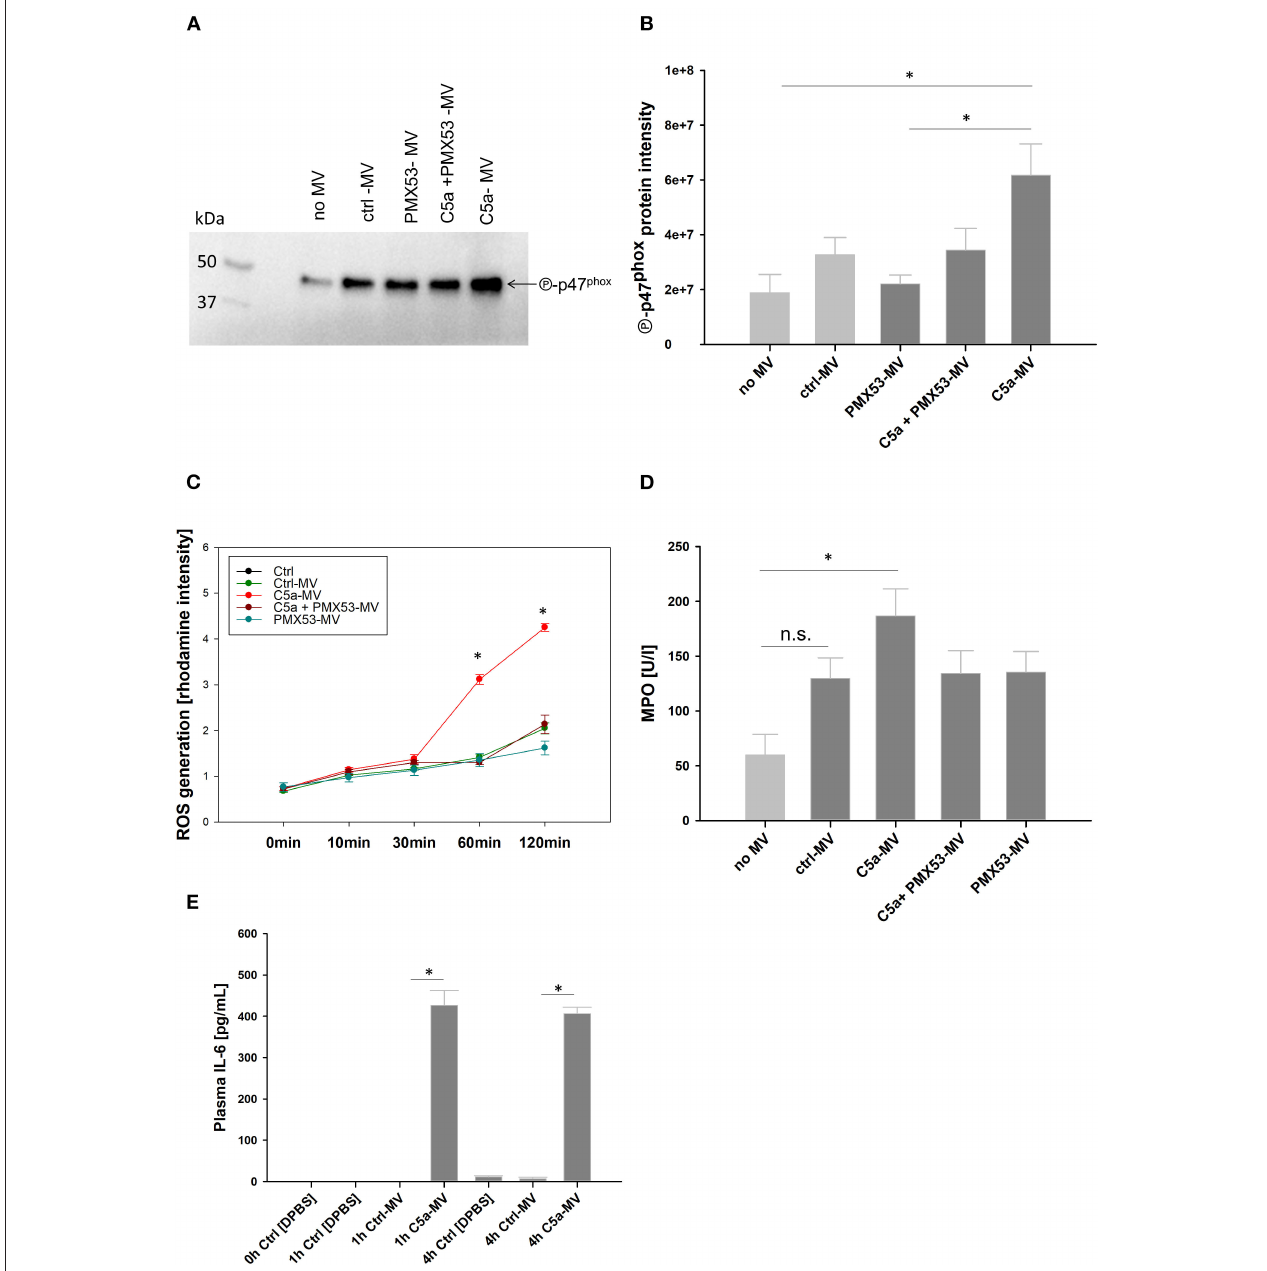
FIGURE 7 | Inflammatory feature of PMN-derived MVs. (A) One representative immunoblot probed for phospho-p47 phox of whole cell lysates from PMNs. PMNs were treated with C5a, C5a and PMX53, and PMX53 only. Untreated PMNs served as control. Afterwards, PMNs from autologous donors were incubated with the generated MVs for 1h at 37 ◦ C. PMNs without MV stimulation served as control. (B) Quantification of phospho-p47 phox signal intensity of PMNs whole cell lysates from three donors. * p < 0.05 compared to PMN without MV control. (C) Time-dependent ROS generation in PMNs incubated with MVs, n = 3, * p < 0.05. (D) MPO amount in PMN supernatants after incubation with MVs, n = 3 * p < 0.05. (E) C5a-gerenerated MVs were incubated in whole blood from autologous donors for 1h and for 4h, respectively. IL-6 was determined in plasma by ELISA. n = 5 per group, * p <